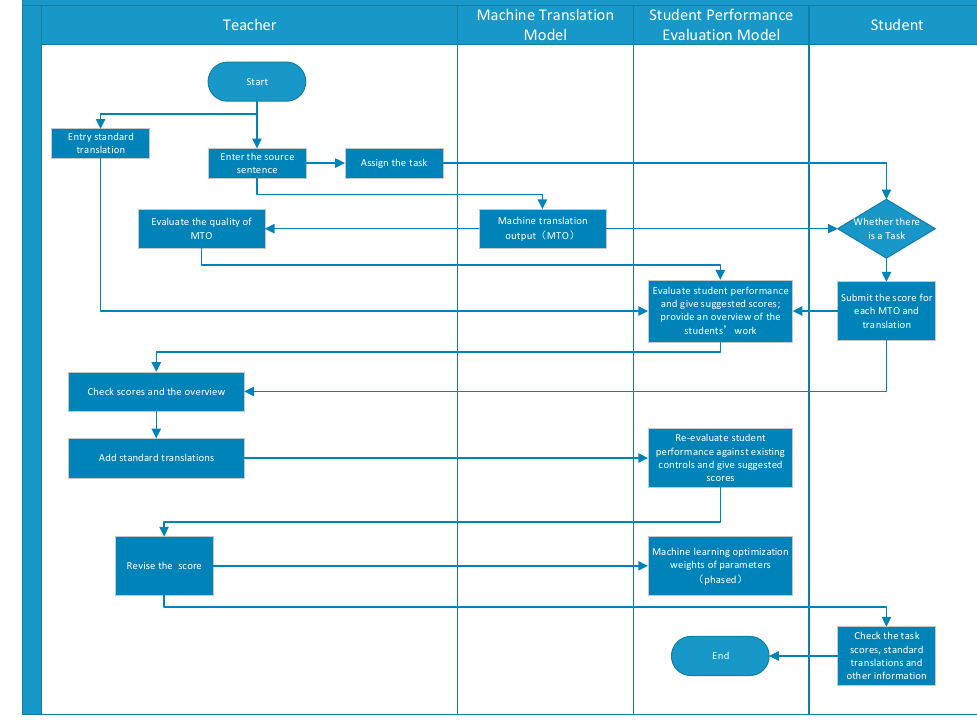
Figure 2. The workflow of TFCAS.